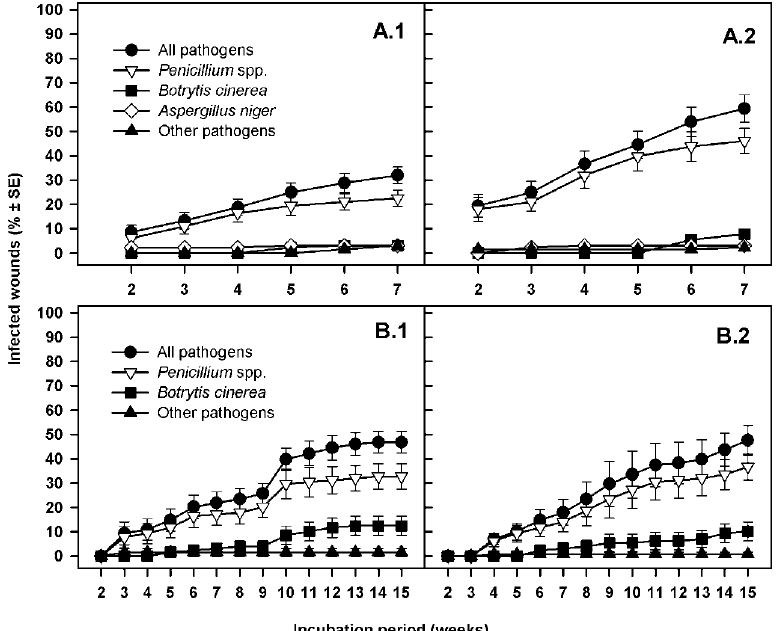
Figure 4. Incidence of postharvest diseases caused by wound pathogens on pomegranates cv. Mollar de Elche from two orchards (1 and 2). The fruit were artificially wounded and incubated at 20ºC for 7 or 15 weeks. Data from two consecutive seasons, 2005 and 2006 (A and